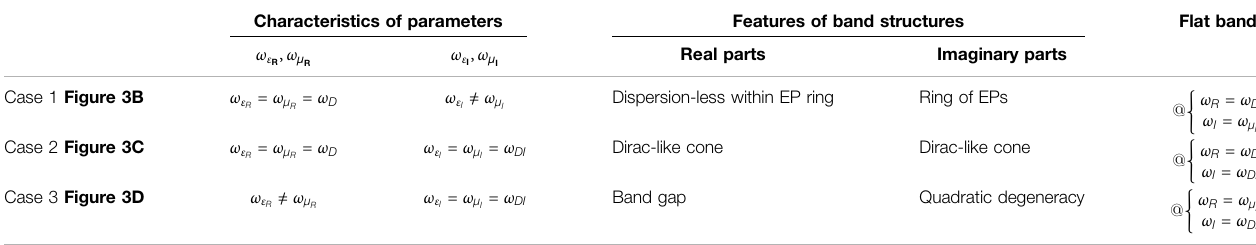
TABLE 1 | Features of band structures of non-Hermitian